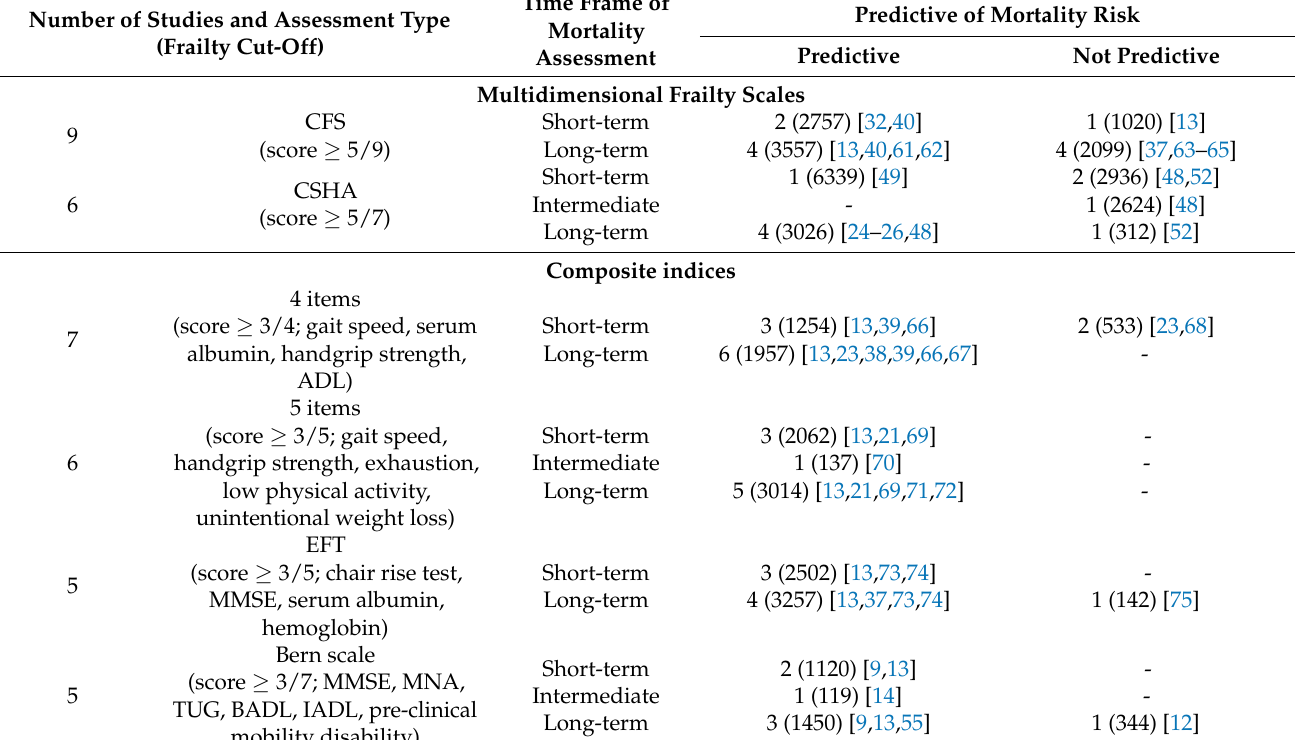
Table 2. Summary of the most-used multidimensional frailty scales and composite indices found to be predictive or not predictive (number of studies and (total patients)) of mortality risk over the short term ( ≤ 30 days), intermediate term (>30 days to <1 year) and long term ( ≥ 1 year).